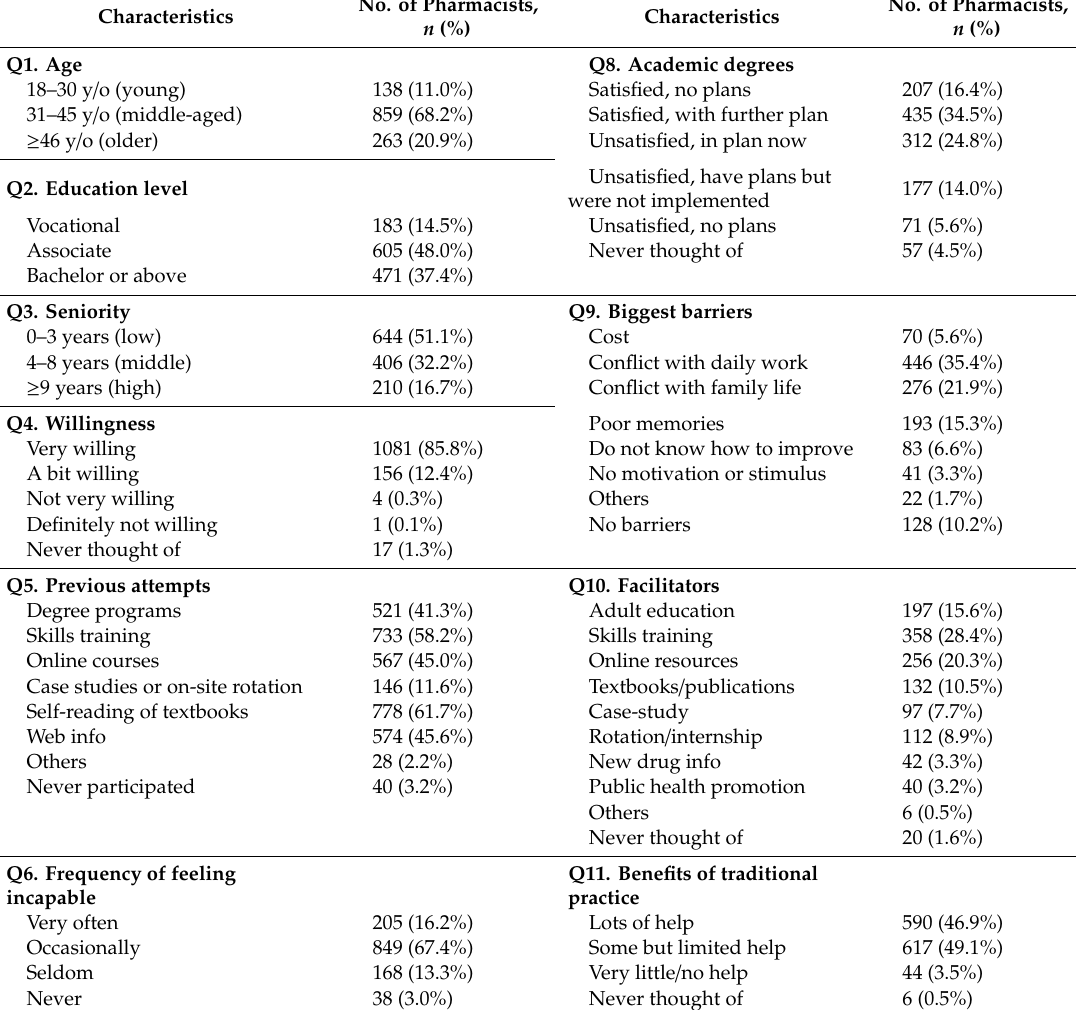
Table 1. Community pharmacists’ answers to the questionnaire ( n =